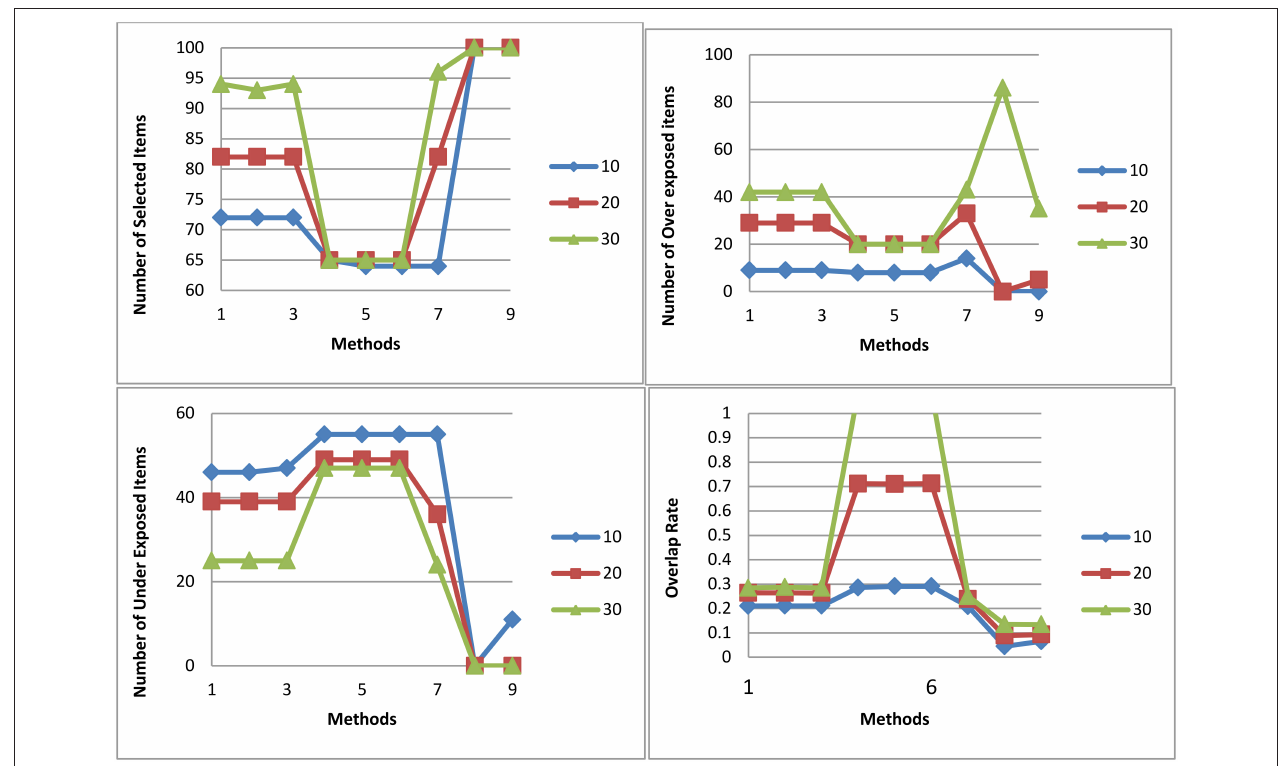
FIGURE 6 | Number of selected items, number of over exposed items, number of under exposed items, and Item overlap rate for all three test lengths and 9 procedures for selection method M2.